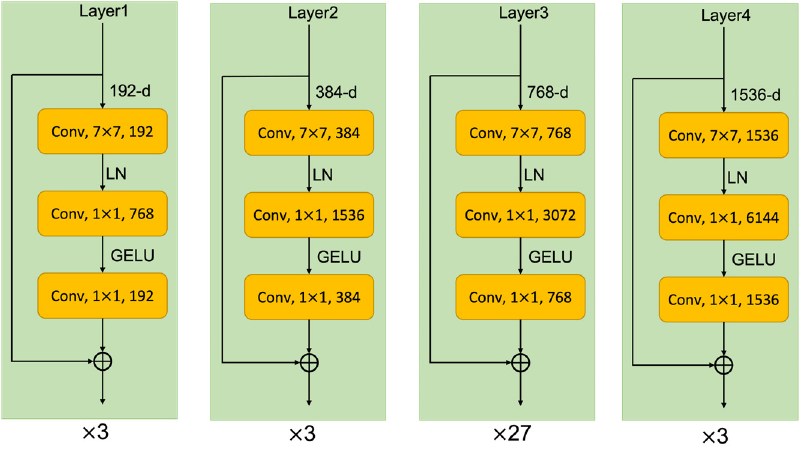
Figure 2. ConvNeXt structure.